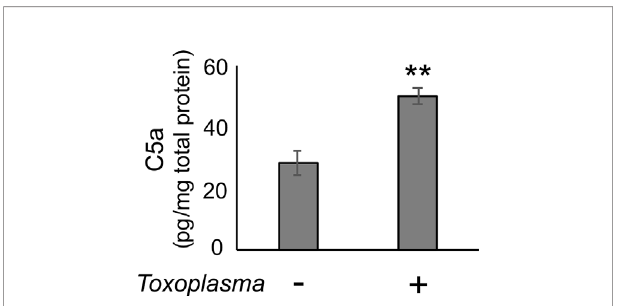
FIGURE 3 | C5a increased in the cerebral cortex after Toxoplasma infection. One month after infection, C5a protein levels in the cortical tissue lysates were measured by ELISA. Data are normalized by total protein and presented as means ± SEM (n=4). ** p < 0.01 (Student ’ s t-test vs. control). The representative outcome of two independent experiments are